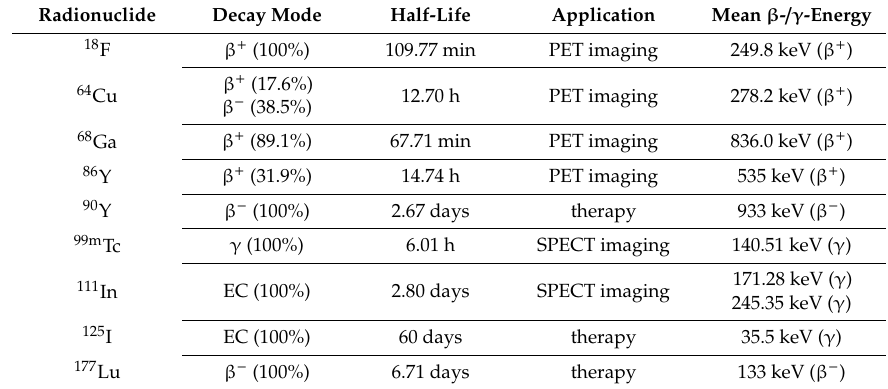
Table 2. Decay characteristics of radionuclides used for heterobivalent peptide labeling [108–110]. Radionuclide Decay